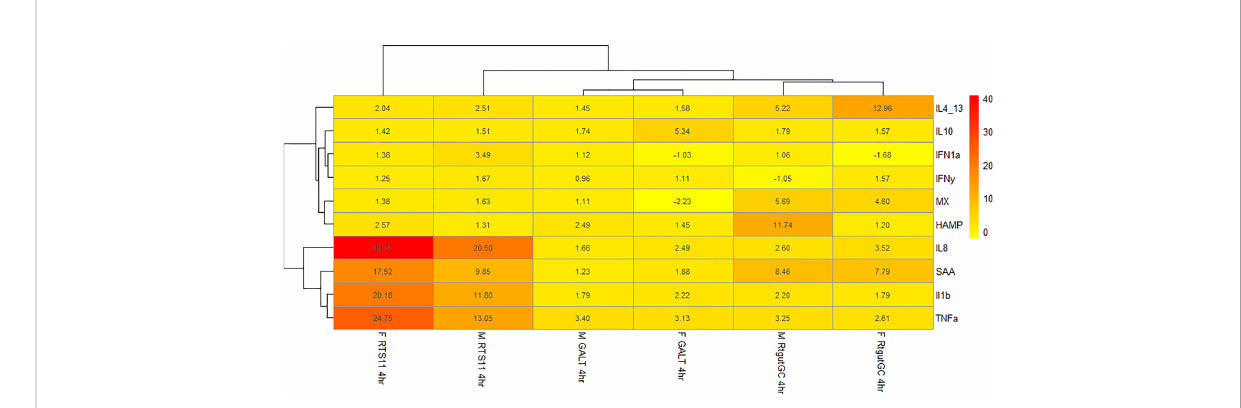
FIGURE 6 Heatmap of fold change for samples stimulated with either M-glucan or Fibosel across all three cell culture